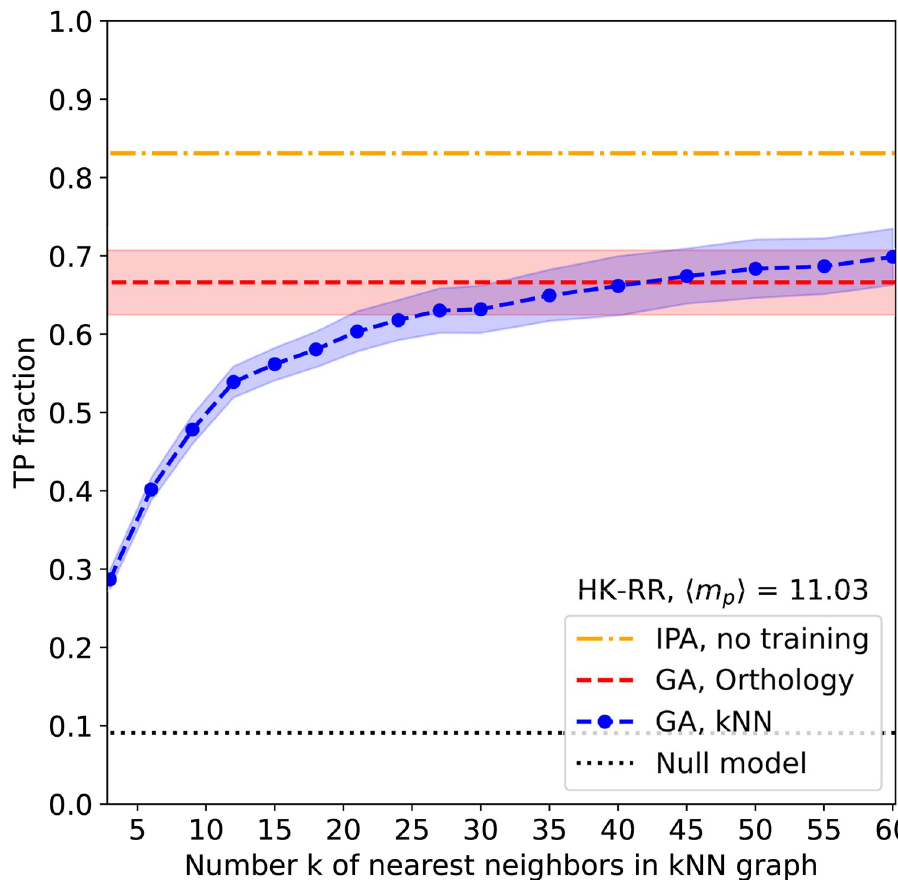
Fig 2. Performance of graph alignment. The mean fraction of true-positive pairings (TP fraction) is shown as a function of the number k of nearest neighbors in the kNN graph for 100 GA realizations (blue). Performance for the orthology graph is also shown (red)—but note that it does not depend on k . Error bars (shaded regions) correspond to one standard deviation. The mean TP value of the IPA starting without any training set of known paired sequences is shown for comparison (yellow). It was obtained using N increment = 6 and by averaging over 50 replicates that differ in their initial random pairings, cf. Materials and methods . The dotted black line shows the average TP fraction obtained for random HK-RR pairings within species (null